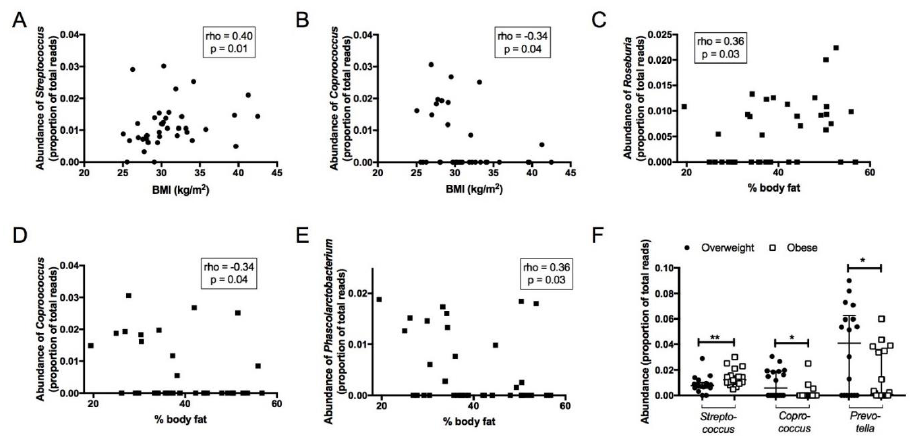
Figure 4. ( A ) The Spearman correlation between BMI and Streptococcus. ( B ) Spearman correlation between BMI and Coprococcus. ( C ) Spearman correlation between %body fat and Roseburia. ( D ) Spearman correlation between %body fat and Coprococcus. ( E ) Spearman correlation between %body fat and Phascolarctobacterium. ( F ) Differences in faecal microbiota between overweight and obese groups.